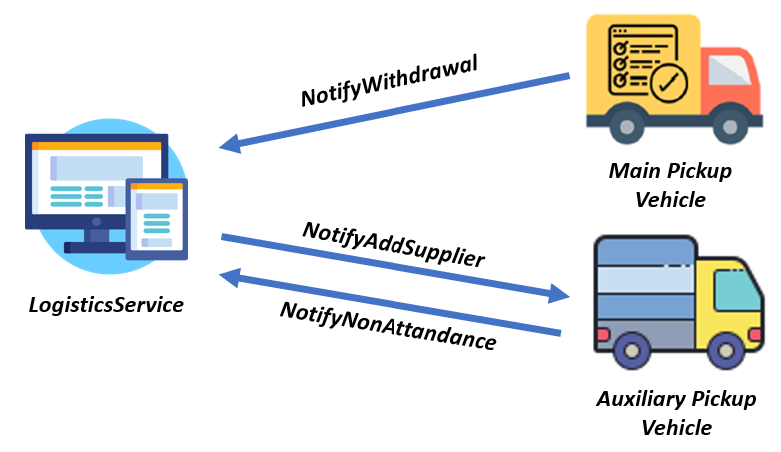
Figure 5. Traffic jam messages when the auxiliary vehicle cannot perform the